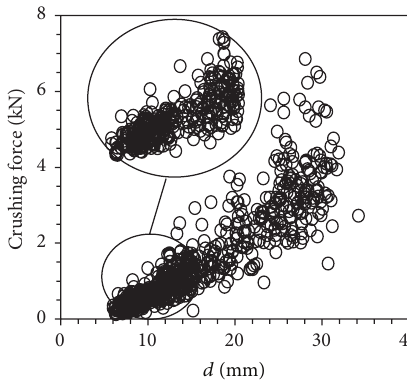
Figure 6: Particle shape type.